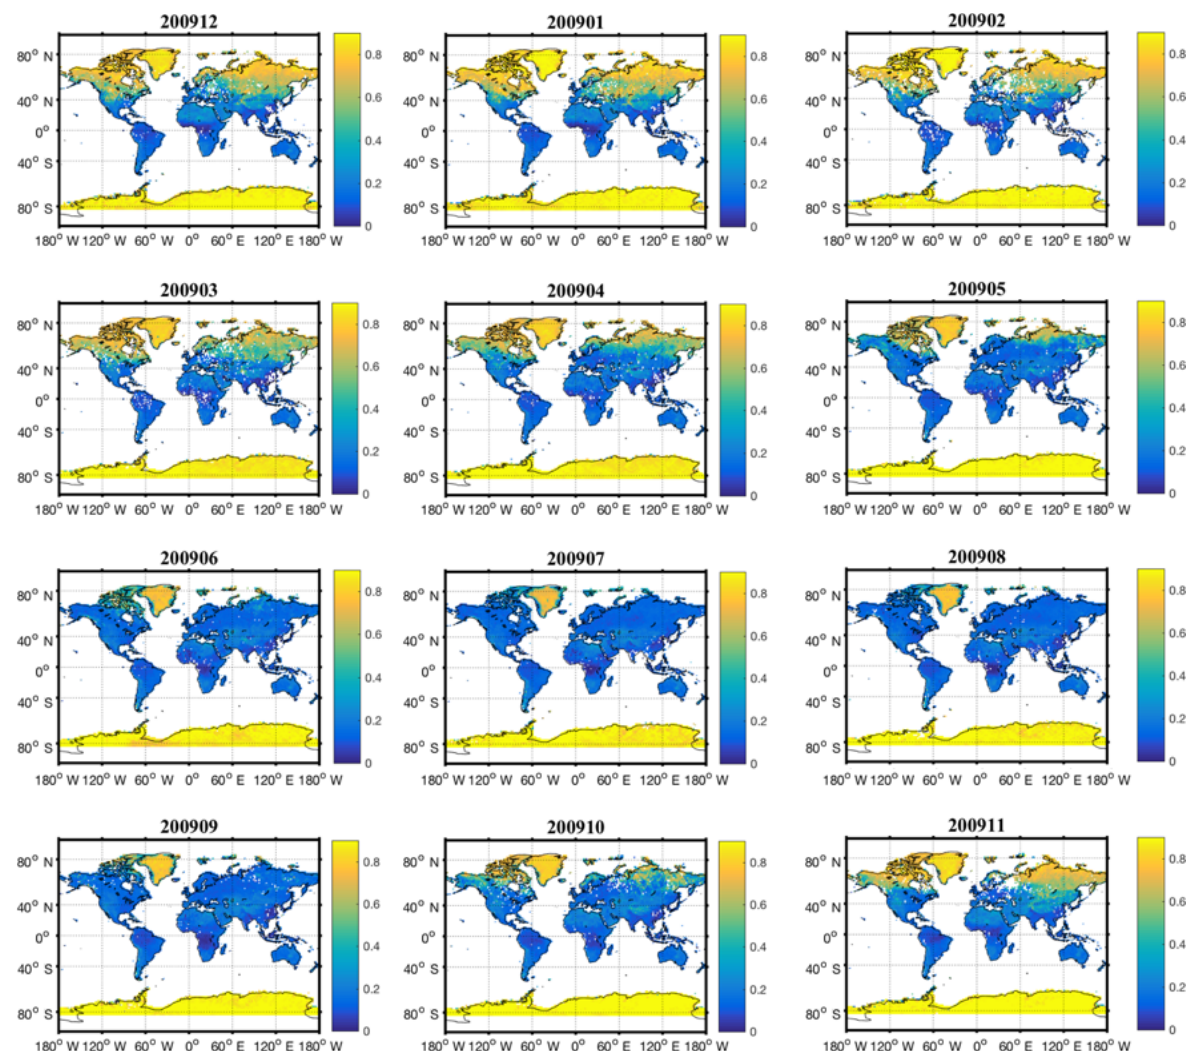
Figure 10. The monthly CALIOP surface reflectance at 532nm for clear sky conditions in 2009. The colors represent the value of surface